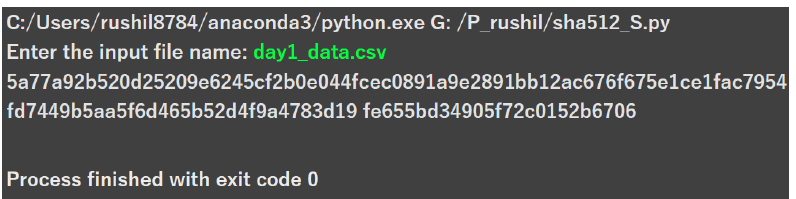
Figure 6. Confusion matrix for the proposed AI-ADP scheme.